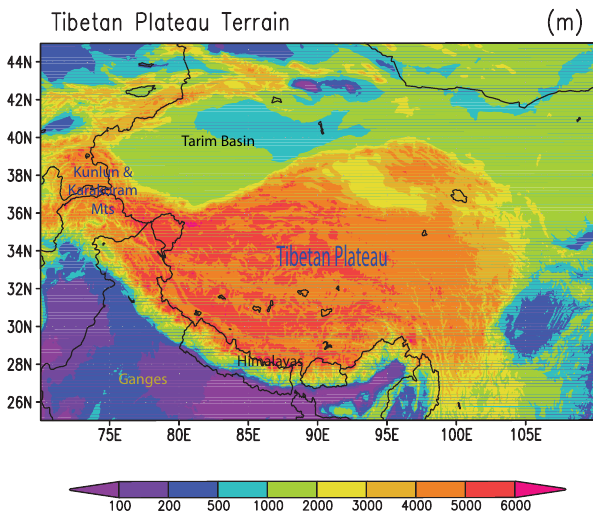
Fig. 1. Terrain of Tibetan Plateau (Unit: